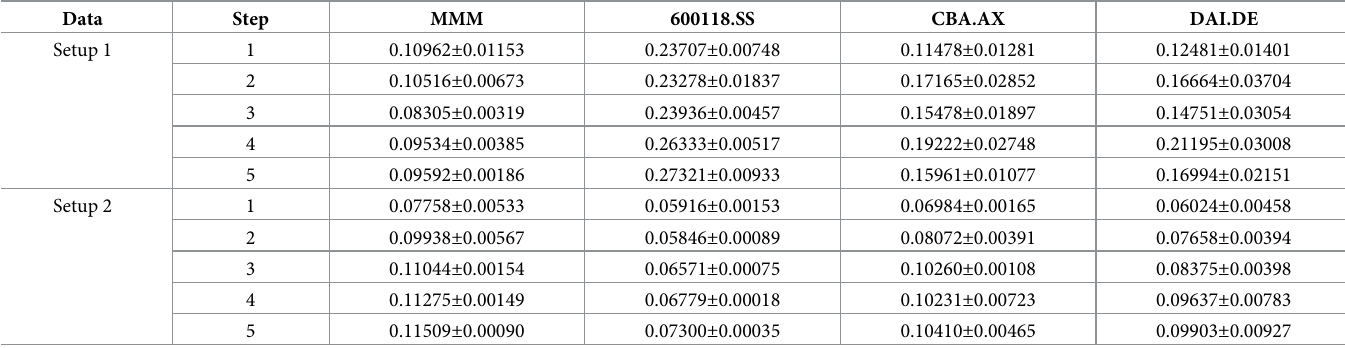
Table 4. Multi-step-ahead prediction (RMSE) during